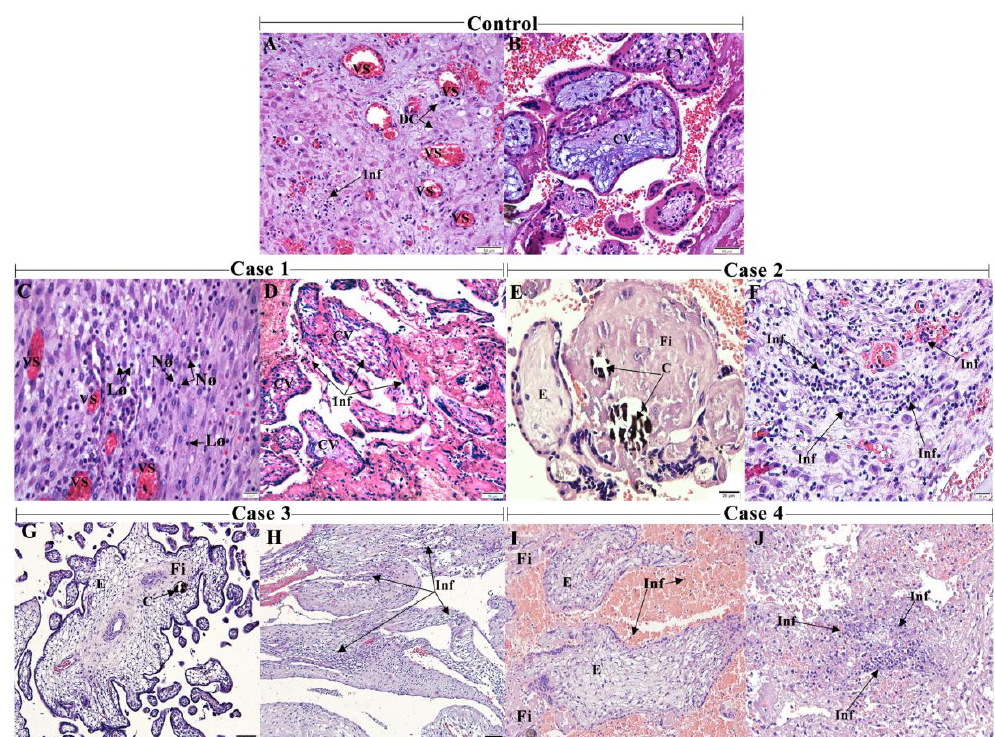
Figure 1. Histopathological analysis of the aborted materials detected an inflammatory environment: ( A ) abortion material from a healthy patient without any infectious disease history during pregnancy (control) showing decidual cells (DC) and ( B ) decidual vessels (DV) with the regular aspects. ( C ) Case 1 exhibiting decidua with mononuclear and polymorphonuclear— lymphocytes (Ly) and neutrophils (Nø) ( D ) and decidua with inflammatory infiltrate (Inf). ( E ) Case 2 with villous edema (E), the deposition of fibrinoid material (Fi) and calcification (C) ( F ) and decidua with intense inflammatory infiltrate. ( G ) Case 3 with dysmorphic villi with edema, focal areas of the deposition of fibrinoid material and calcification ( H ) and deciduitis. ( I ) Case 4 with intervillous space with inflammatory cells, villous edema and areas of the deposition of fibrinoid ( J ) and deciduitis. 10 µ m = 1000 × , 20 µ m = 400 × , 50 µ m= 200 × , 100 µ m = 100 × .